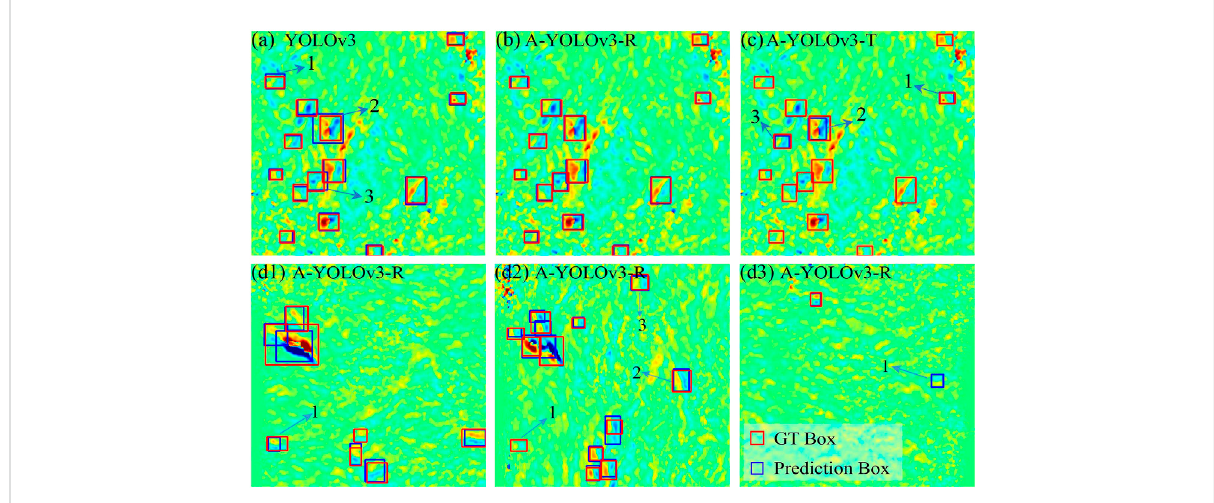
FIGURE 6 The detection result of different networks (in radar coordinate: 416 by 416 pixels). The gradients are scaled to [ − 4, 4] radians. Note that some yellowish and light bluish bands are visible in the phase-gradient maps, and there is background noise related to the shortening and shadowing effects. Actually, magnitudes are very small compared with the areas with localized deformation. The box with the blue boundary is the prediction from the network and with the red boundary is the ground-truth (GT) Box. Sub-plates (A,B, and C) represent the landslide detection result by YOLOv3,A-YOLOv3-R,andA-YOLOv3-T, respectively. Sub-plates (D1,D2) displaythestacked phasegradientsintheazimuth andrangedirectionof another sample and show mis-location cases of the A-YOLOv3-Rwith numbers. Sub-plate (D3) shows a case (indicated as 1) that is detected by our network without being